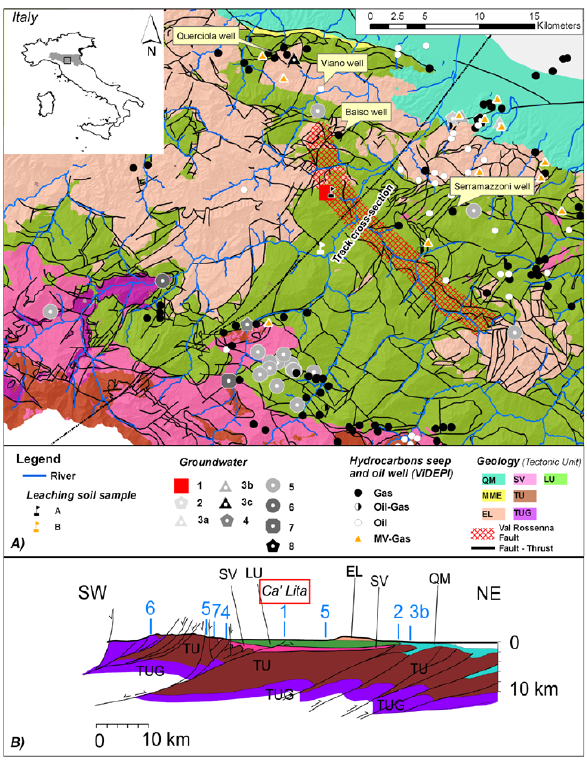
Fig. 1. (a) Simplified map of geologic units of the northern Apen- nines. (b) Geological cross section (modified after Vannucchi et al., 2008). Legend: geologic units (TU: Tuscan Units; TUG: Triassic Evaporites; LU: Ligurian units; EL: Epiligurian Units; SV: Sestola- Vidiciatico unit; MME: Messinian Evaporites; QM: Post Messinian Units). Water springs, water samples, hydrocarbon seeps and oil wells (1: Ca’ Lita samples; 2: Salvarola baths; 3a: Mud volcano Ni- rano; 3b: Mud volcano Monte Gibbio; 3c: Mud volcano Regnano; 4: Quara baths; 5: Common shallow groundwater; 6: Poiano spring; 7: Morsiano spring; 8: Rio Petrolio hydrocarbon seep). Soil samples for leaching experiments (A: weathered Ca’ Lita material; B: in situ rock